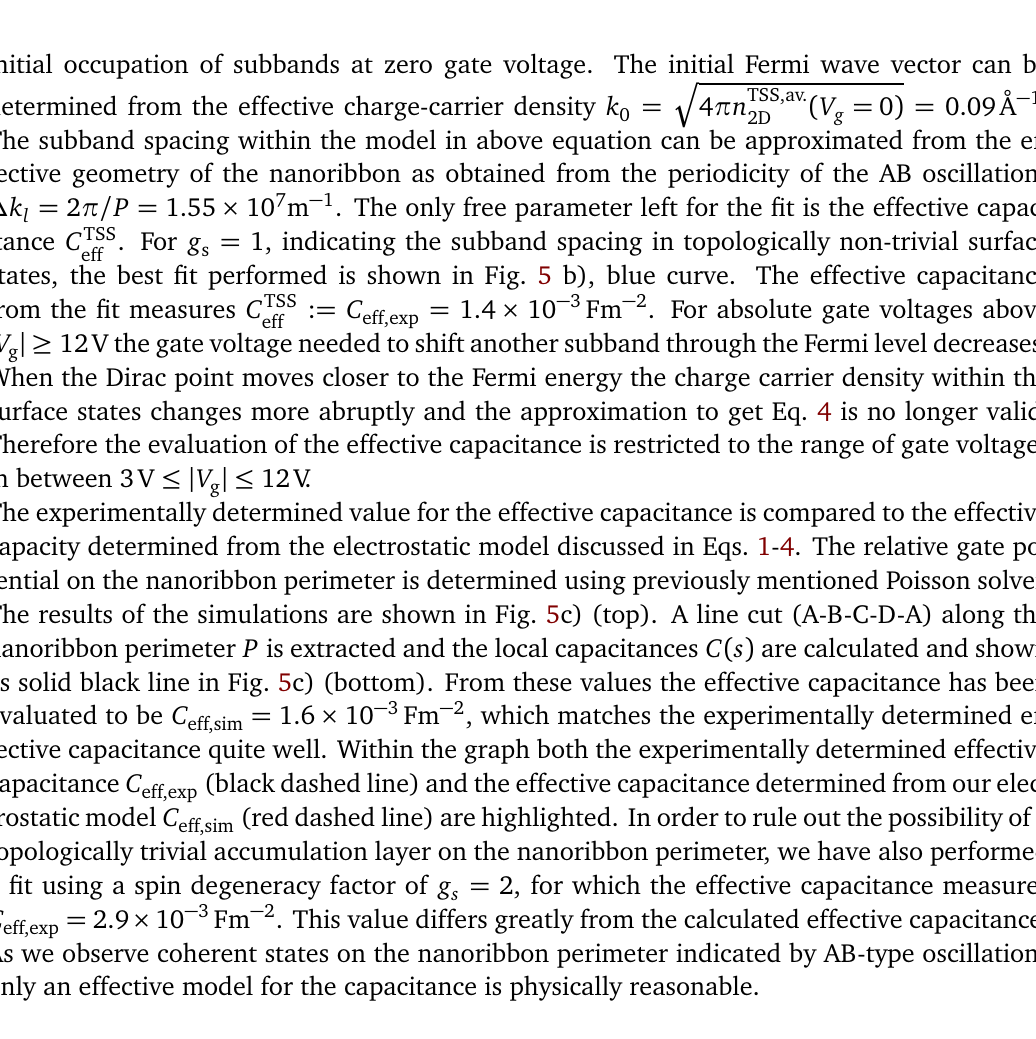
Figure 5: Gate-dependent subband spacing in the narrow nanoribbon. a) The aver- age oscillation pattern of line-cuts at full integer (black curve) and half-integer (red curve) values of the magnetic flux quantum extracted from Fig. 4 a) are shown. The grey dashed lines show the extracted subband indices N , which are shown in b) as a function of the absolute applied gate voltage V . The black lines indicate the range g of values shown in a). The blue dashed line indicates the fit performed following Eq. 7 and the values for the best fit performed are mentioned within the inset. c) Simulated relative gate potential V / V along the perimeter of the nanoribbon (top) g and calculated local capacitances C ( s )